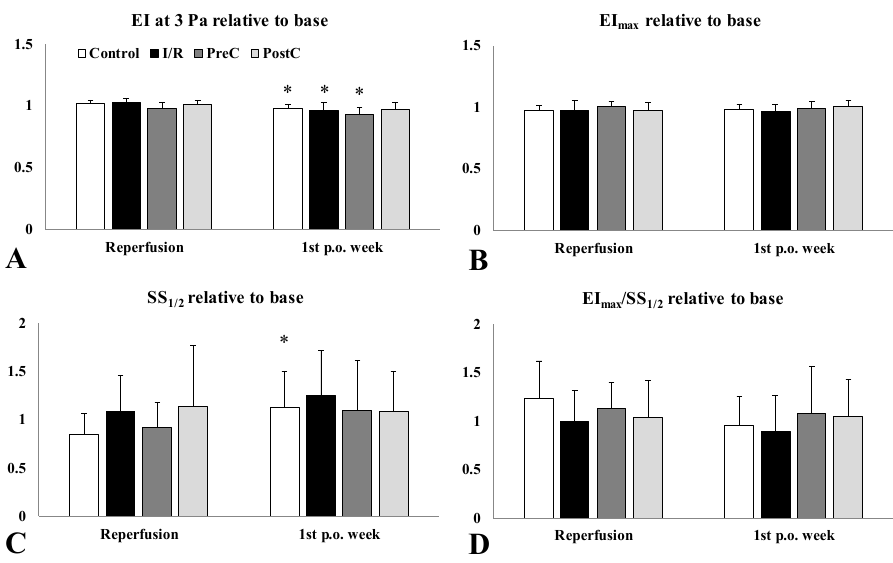
Figure 2. Relative values of elongation index (EI) at 3 Pa ( A ), maximal elongation index (EI max ) ( B ), shear stress at half EI max (SS 1/2 ) ( C ), and the ratio of EI max and SS 1/2 ( D ), compared to their base values (as 100%) in the control, the ischemia-reperfusion (I/R), the ischemic pre-conditioning (PreC) and the ischemic post-conditioning (PostC) groups. Means ± S.D., * p < 0.05 vs. reperfusion.